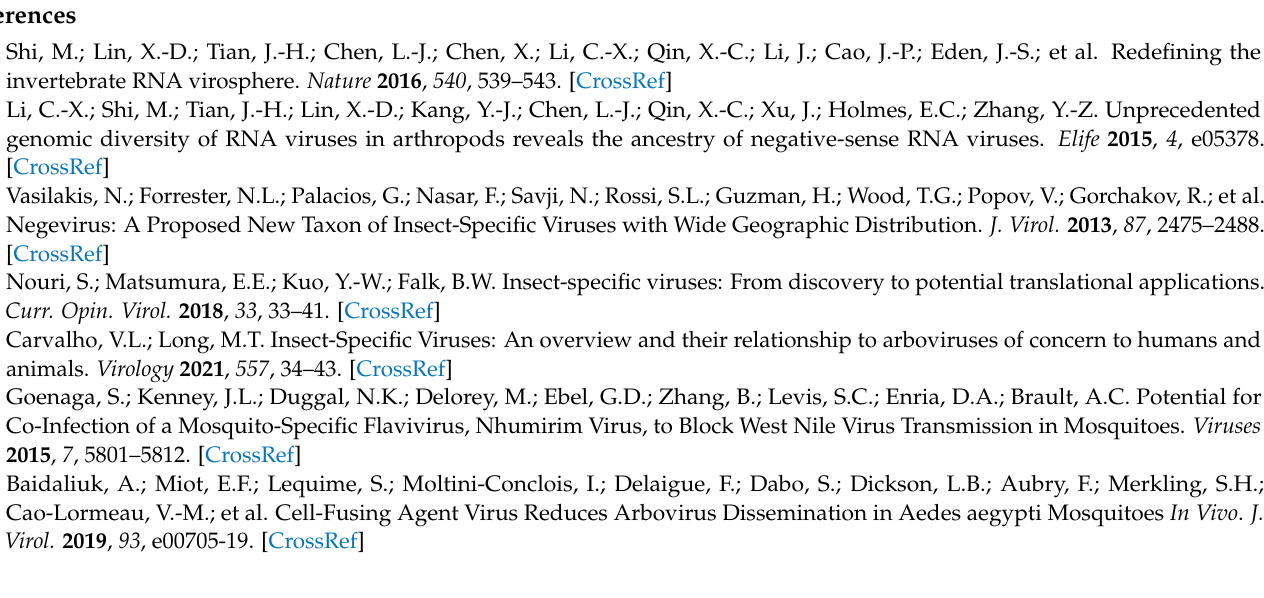
Figure S1: The Genetic structure of Aphid lethal paralysis virus and putative reads found in A. sinensis (% represents amino acid similarity and ? refers to unknown sequences), Figure S2: The sRNA plot of ASCV1, Table S1: Primers used in this study, Table S2: Abbreviations of virus names and GenBank accession numbers used in this study, Table S3: Amino acid/nucleotide identity analysis of ASNV1 based on the conserved amino acid and nucleotide sequence of the RdRp domain, Table S4: Amino acid/nucleotide identity analysis of ASIV1 based on the conserved amino acid and nucleotide sequence of the RdRp domain, Table S5: Amino acid/nucleotide identity analyses of ASCV1 and ASOV1 based on the conserved amino acid and nucleotide sequence of the RdRp